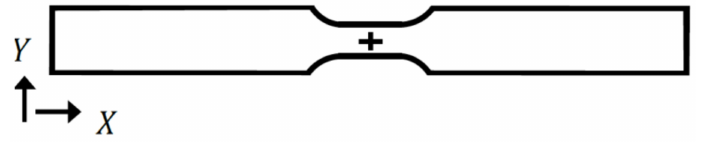
Figure 4. Orientation of line scans for surface